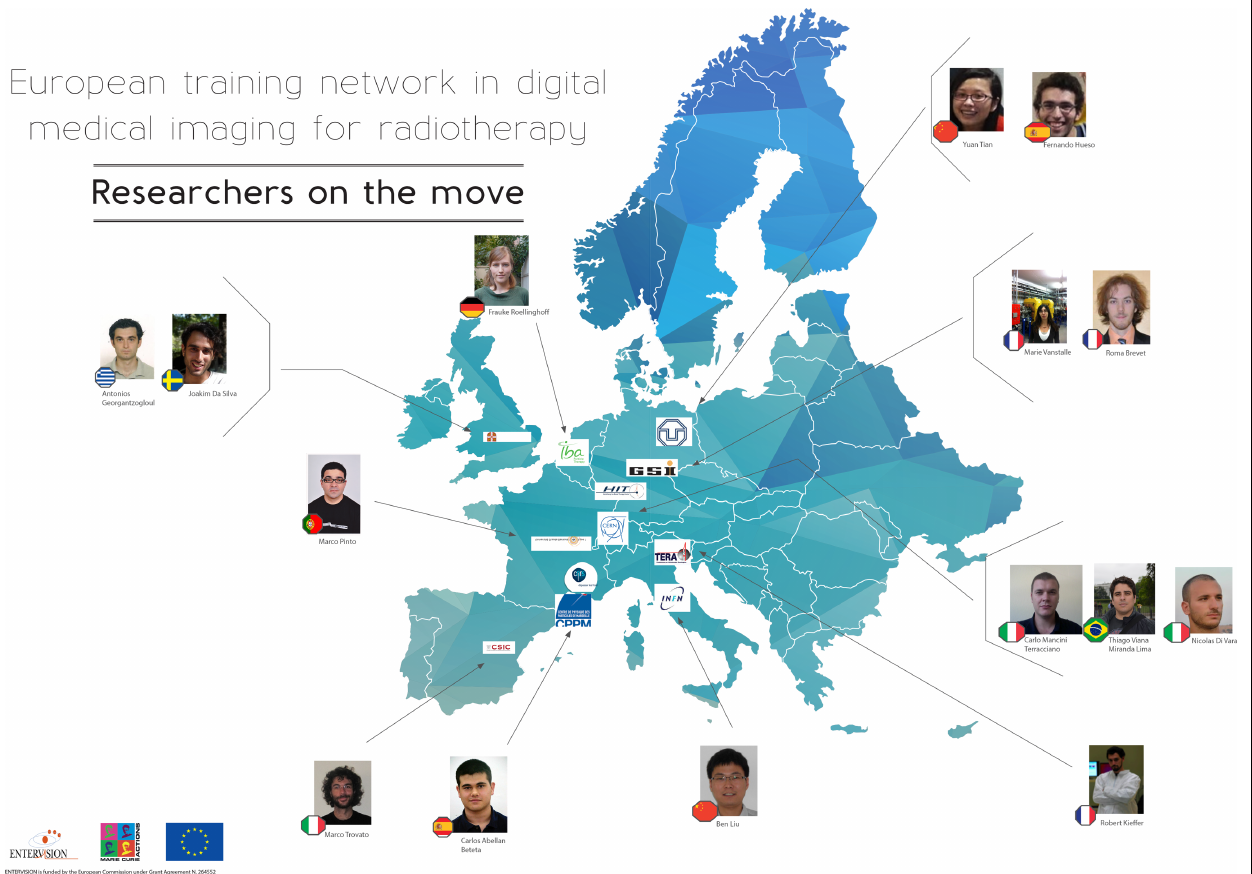
FIGURE 1 | Distribution of ENTERVISION researchers per nationality and recruiting institute